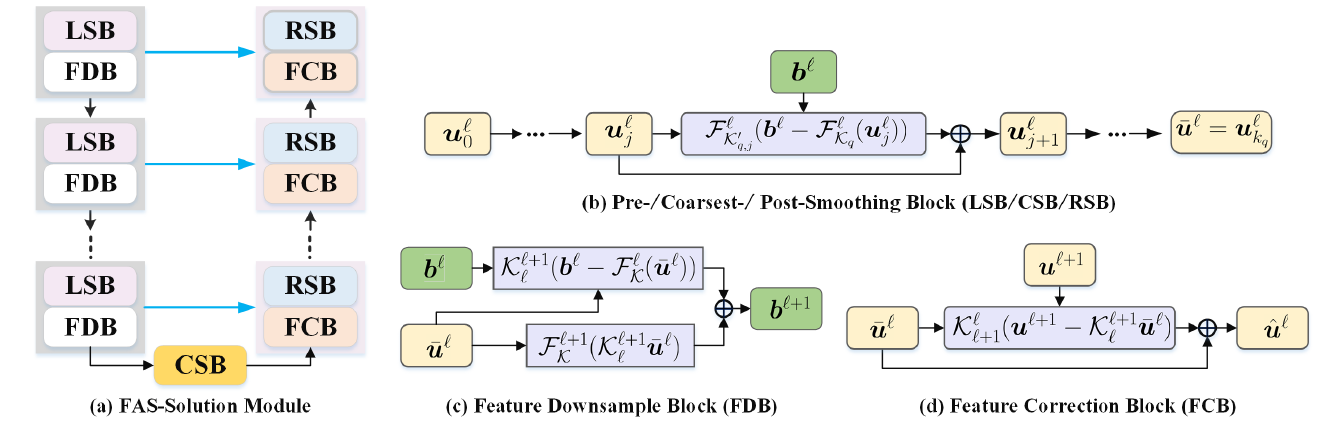
Figure 2. The overall flowchart of the proposed feature extraction module (FAS-Solution module) with the multigrid architecture. It consists of three major ingredients, i.e., pre-/coarsest-/post- smoothing blocks (LSB/CSB/RSB), feature downsample block (FDB), and feature correction block